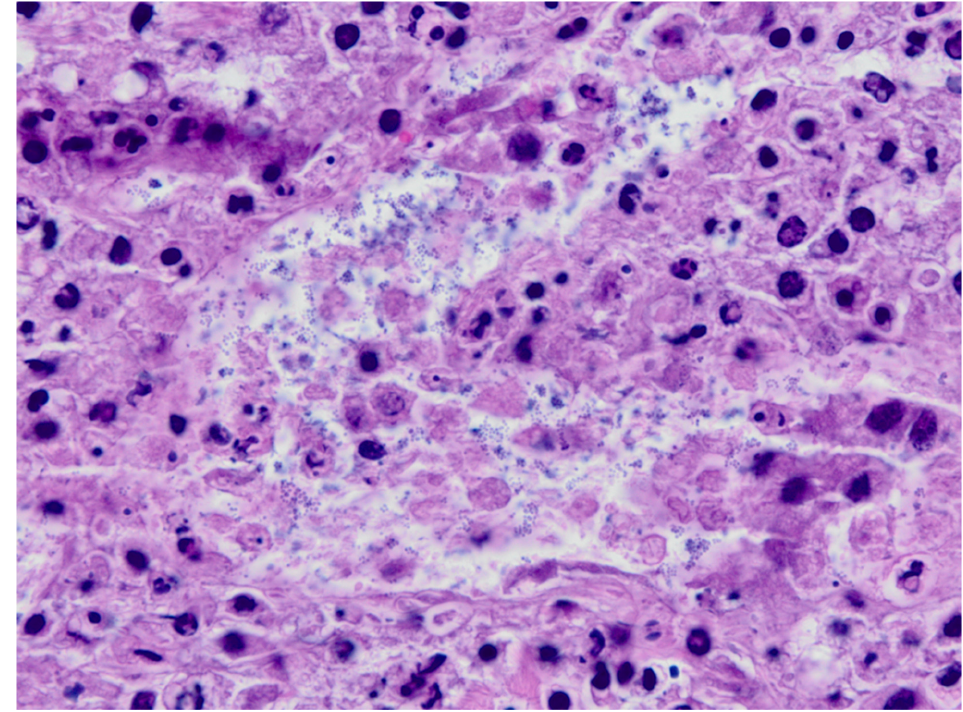
Figure 4. Female juvenile D. delphis Inset of skin lesion in Figure 3. Admixed with degenerate inflammatory cells are numerous bacterial cocci arranged in pairs, aggregates and rare chains. Hematoxylin and eosin, 100× magnification.